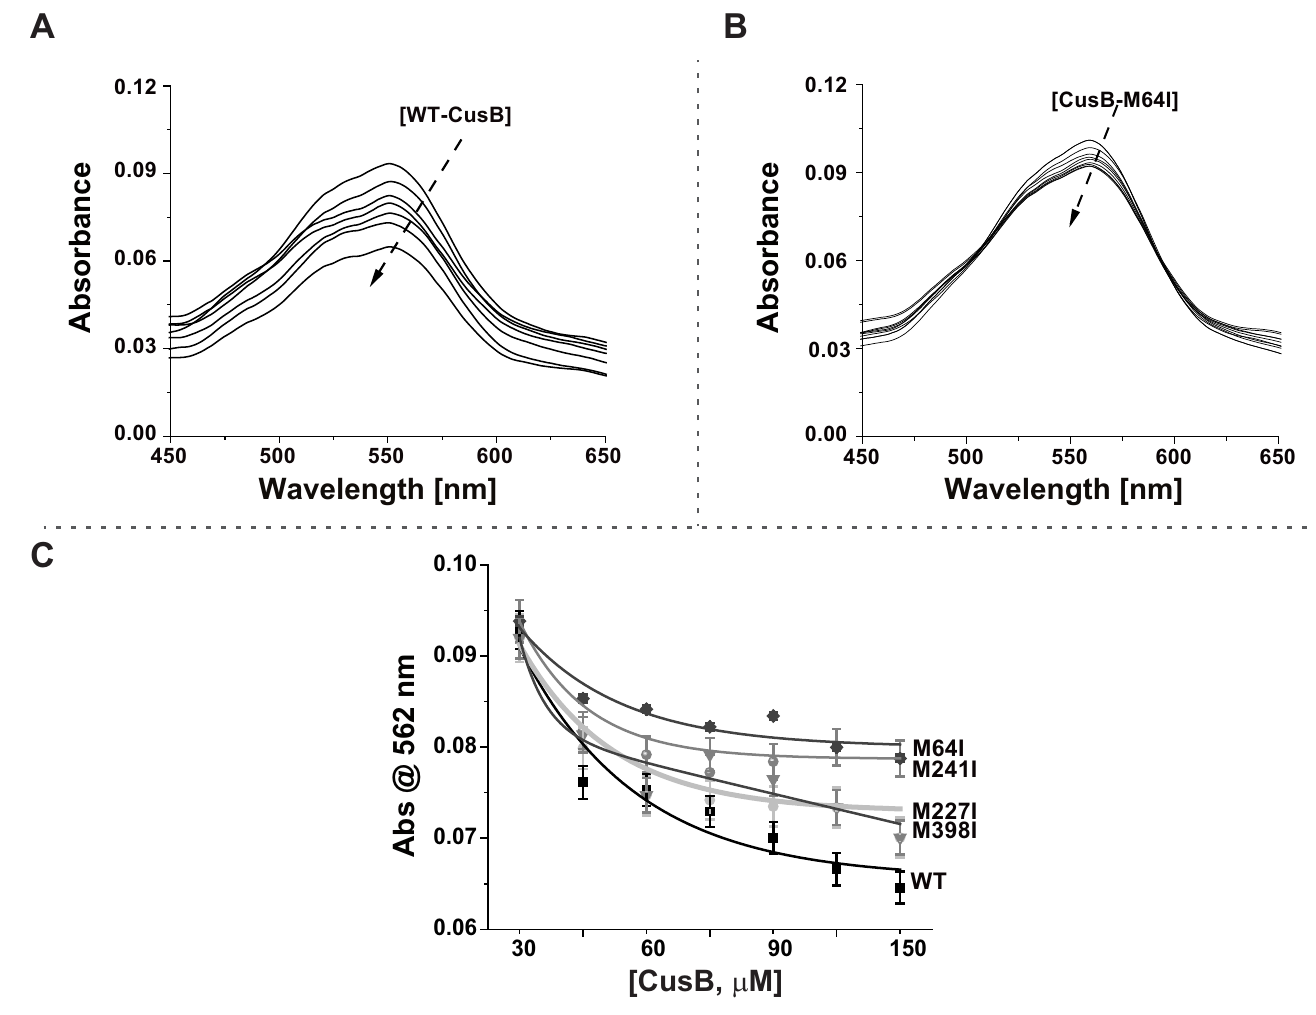
Fig 4. Cu(I) affinity to CusB mutants. Absorption spectra for Cu(I)-(BCA) 2 titrated with A. WT-CusB, B.CusB_M64I, C. Absorbance at 562 nm of Cu(I)-(BCA) 2 titrated with various CusB